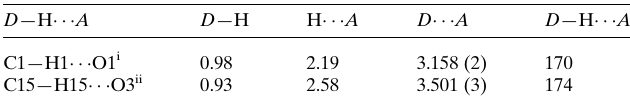
Table 2 Hydrogen-bond geometry (A˚ , (cid:2) ) for 2 .